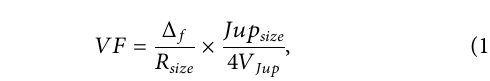
FIGURE 3 | Simulation displaying sensitivity of the MOF channels of PMODE. Here, a lower value represents a higher sensitivity, as we are displaying the ability to measuresmallerDopplershifts — therefore,asensitivity of200 m s − 1 isbetterthanasensitivity of2,000 ms − 1 .Thesechannelsprovidesensitivity overthemajorityofthe Joviandisk.The770 nm Kcellprovidesasteeper(andthusmoresensitive)linecoveringasmalleramountofarea,whilethe589 nmNadoublethasashallower(andthus lesssensitive)pro fi le,coveringalargeramountofareaonthedisk.Panels (A,B) showthemodeledsensitivityfortheKandNacellsrespectively,assumingJupiteris at opposition, while panel (C) shows the Na and K cell sensitivities